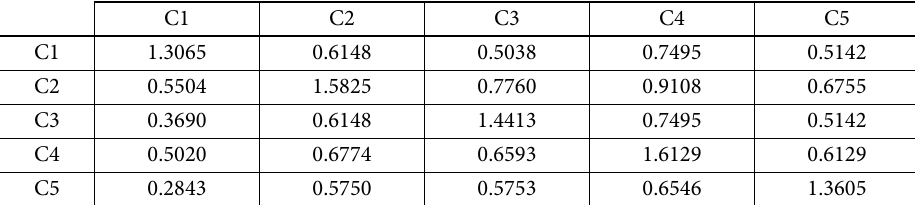
Table 11. Matrix ( I – X ) –1 for inter-cluster relationships